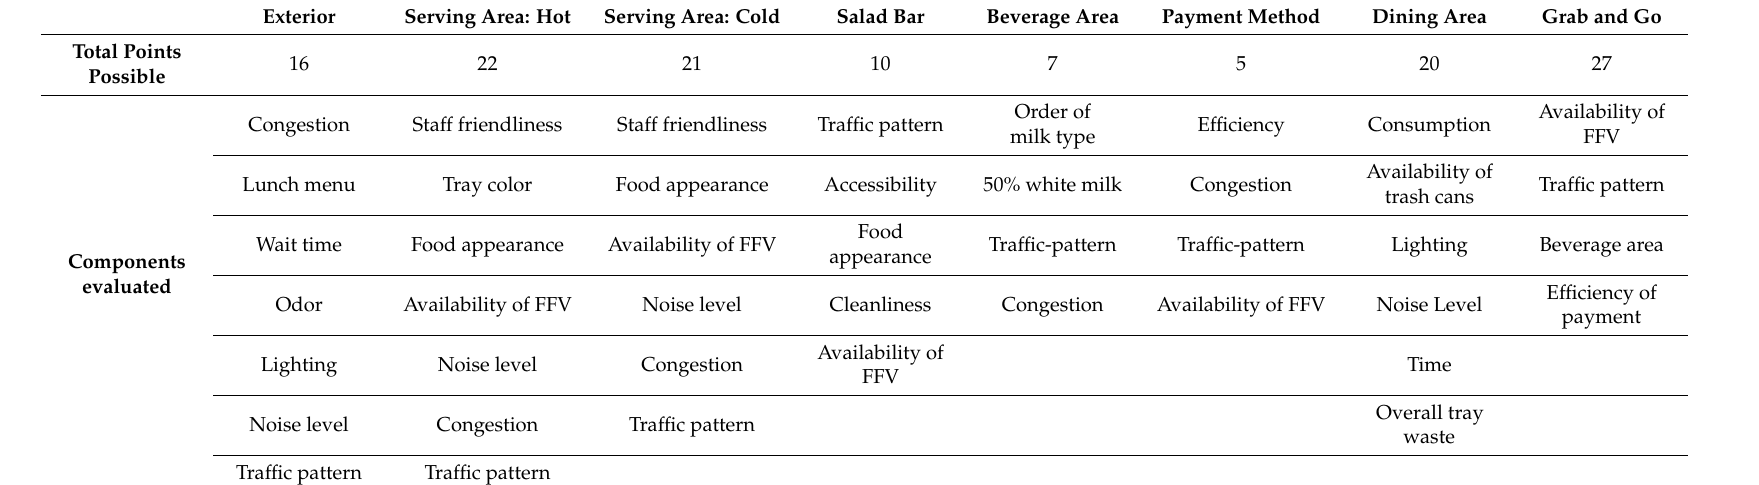
Table 1. NudgeSAT evaluation components and total points for each area of the cafeteria